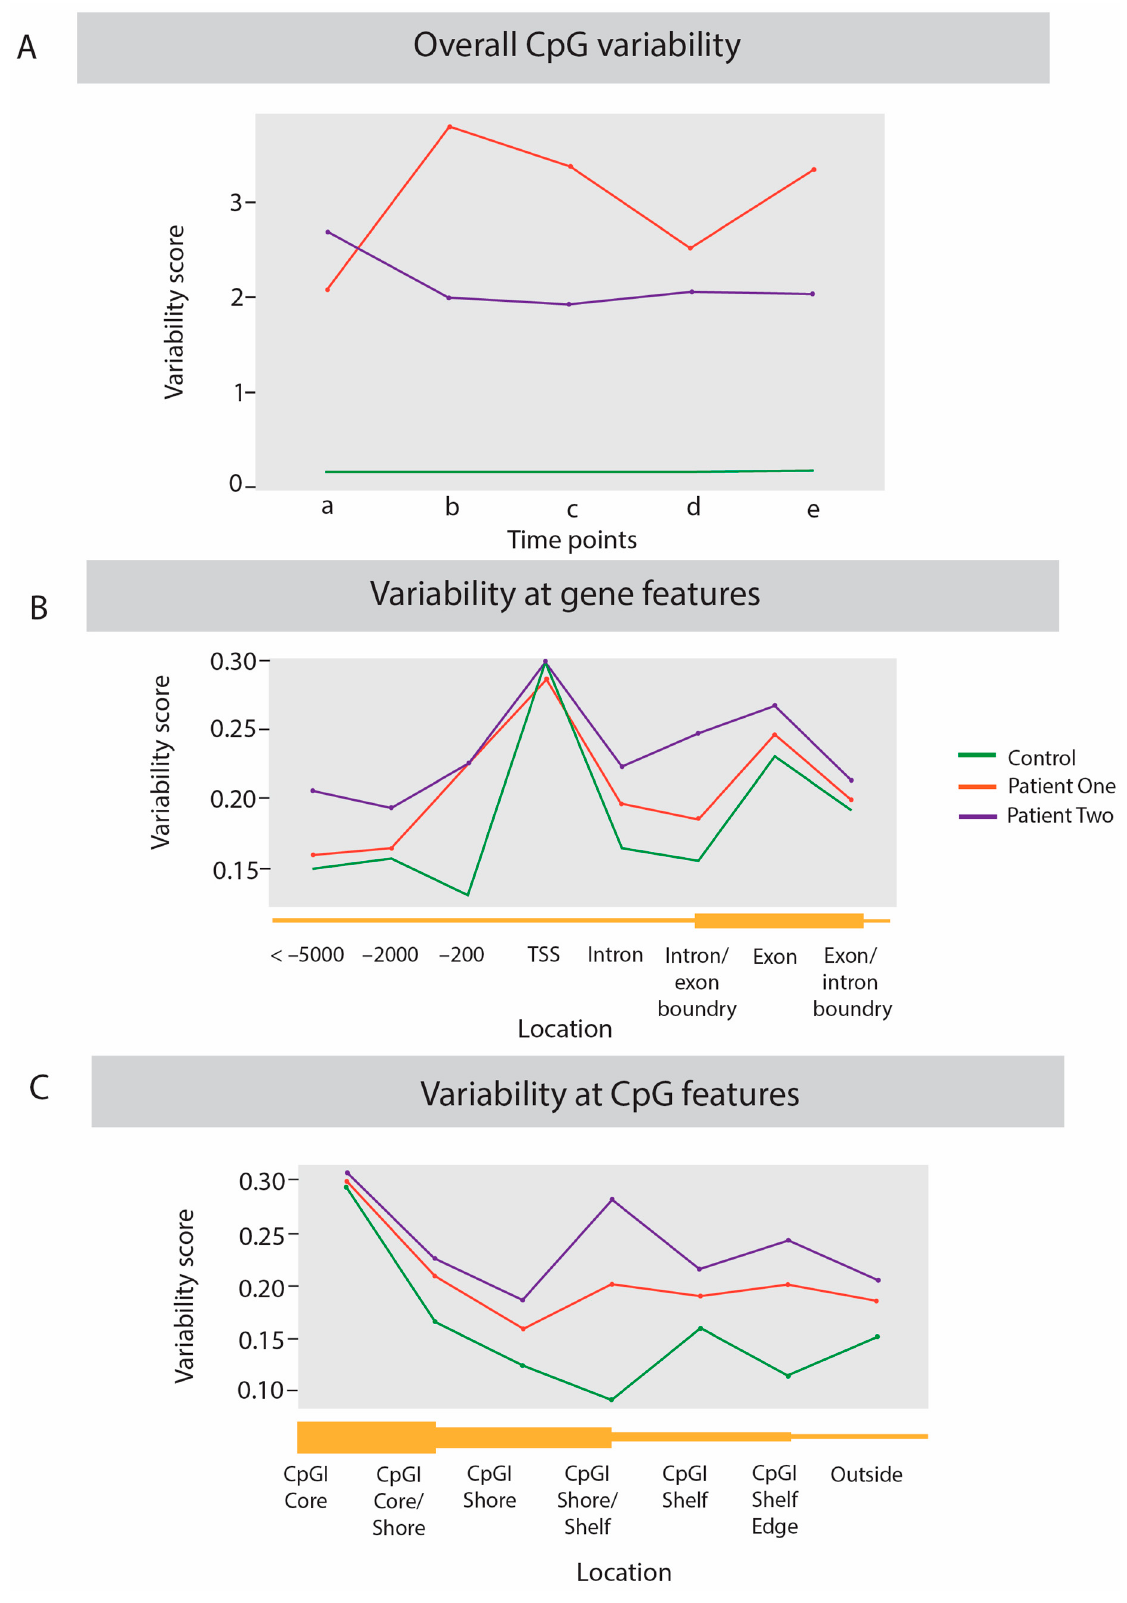
Figure 2. Line plots showing the variability calculated for each individual. ( A ) summary of the statistically significant unique differentially methylated CpG sites at each time point a to e for the two patients and the healthy control. The level of methylation variation was calculated utilising